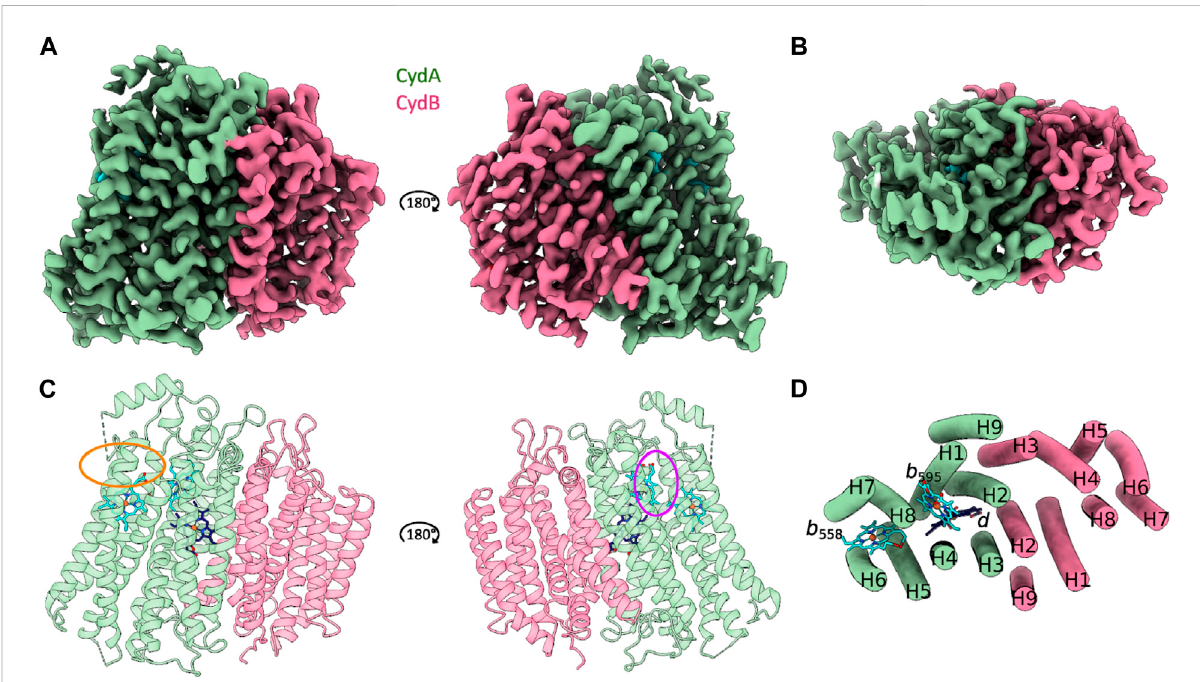
FIGURE 1 CryoEM structure of C. glutamicum cytochrome bd at 2.7 Å resolution. (A and C) Side view representations of the cryoEM map density and its corresponding ribbon model of the heterodimeric C. glutamicum cytochrome bd structure. The substrate quinol binding site 1 at the Q-loop in proximity to heme b 558 is highlighted in orange. The second putative quinol binding site next to heme b 595 is shown in purple. (B and D) Top view representation of the cryoEM map density and the corresponding tube model of the Cgbd structure highlighting the pseudosymmetrical arrangementofthetwo fourhelix bundlesand theadditionalperipheralhelixper subunit. Color code: CydA,green;CydB, pink; b -type hemes,cyan; heme d , dark